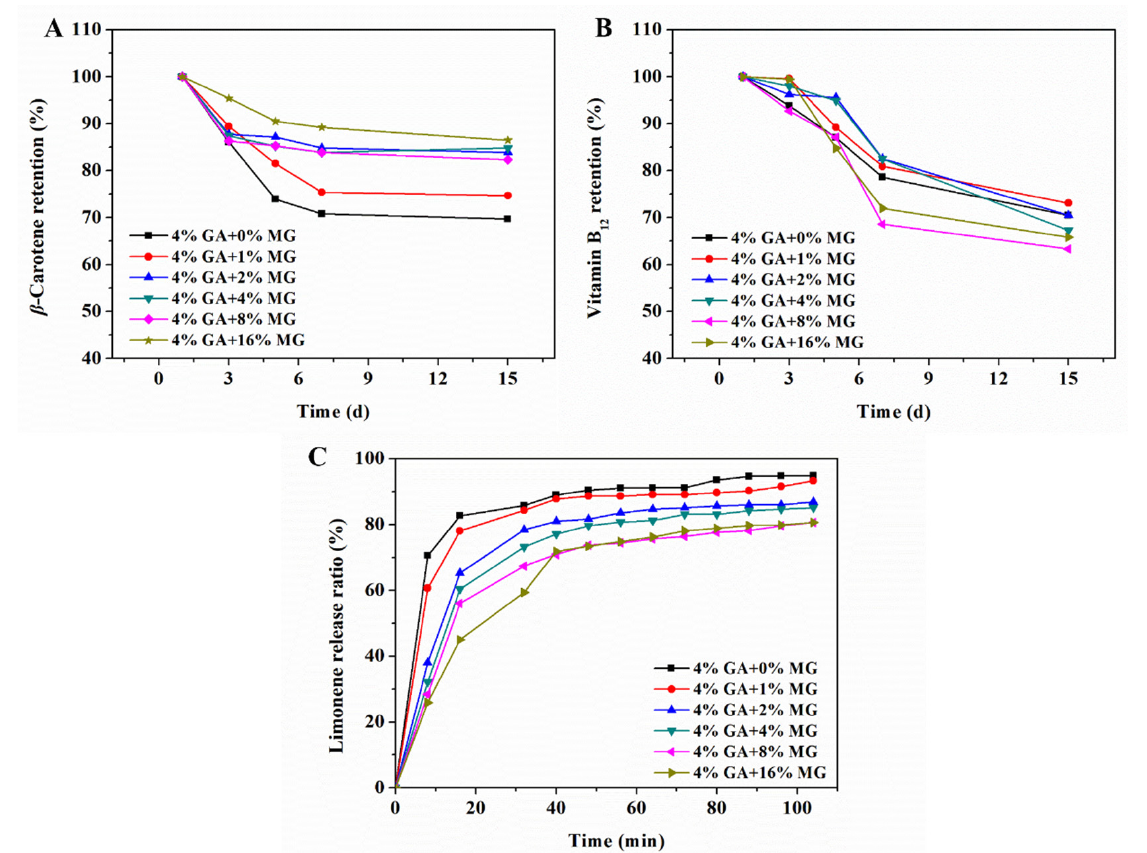
Figure 7. Retention of ( A ) β -carotene and ( B ) vitamin B 12 in the GA − MG dual-structured gel emulsions during storage at room temperature 25 ◦ C). ( C ) Real-time dynamic release profiles of limonene from gel emulsions at 50 ◦